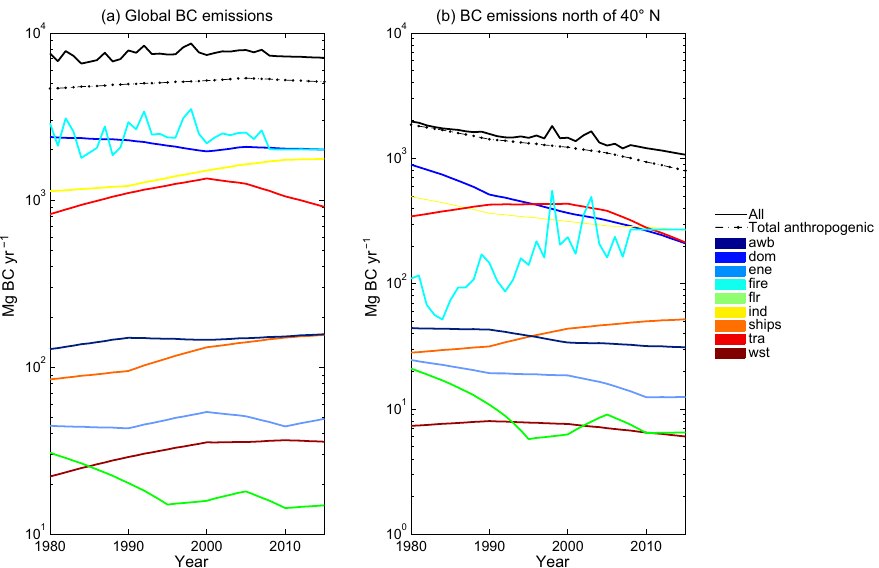
Figure 3. Temporal trend of BC emissions by sector from 1980 to 2015: (a) globally and (b) north of 40 ◦ N. The emission sectors are as follows: all indicates all anthropogenic and natural sources combined, total anthropogenic is all anthropogenic sources, awb is agricultural waste burning, dom is domestic, ene is energy production, fire is natural fires, flr is flaring, ind is industry, ships is shipping, tra is transport and wst is waste incineration. Anthropogenic MACCity BC emissions are from Granier et al. (2011), ECLIPSE flaring emissions from Klimont et al. (2013) and natural fire emissions from Lamarque et al. (2010). Note the logarithmic y